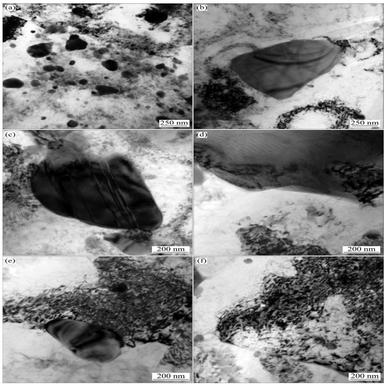
HRTEM micrographs of AA2124/4wt.%B4C coating at rotational speed of 1000 r/min: (a) Fine distribution of B4C particles; (b, c) Single B4C particle; (d) Interface between aluminum matrix and B4C particle; (e, f) Dislocations